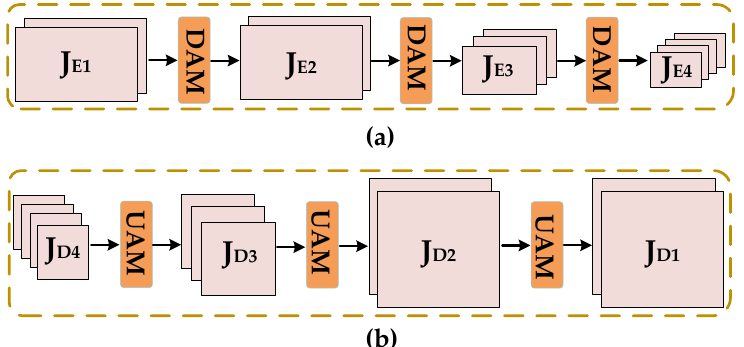
Figure 4. The overall structure of the top encoder, bottom encoder and decoder. Where ( a ) is the structure of top encoder and bottom encoder. In addition, ( b ) is the structure of decoder. The black arrows indicate the transfer information stream. DAM indicates Downsampling Attention Module, UAM indicates Upsampling Attention Module.